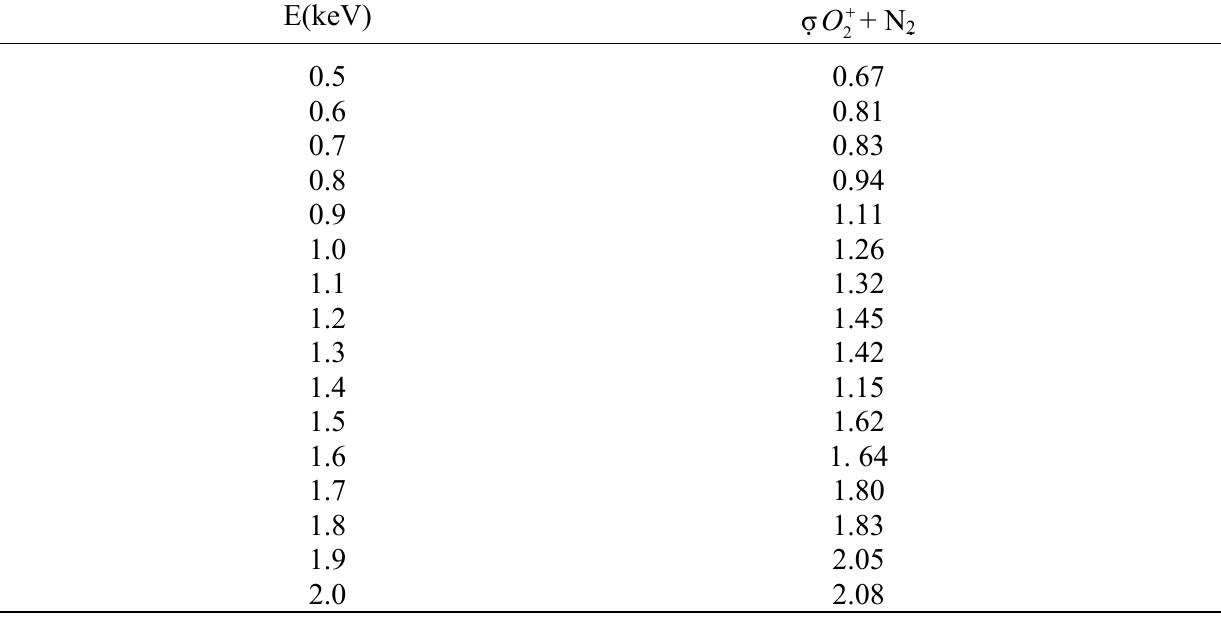
Table 1. Absolute total single-electron-capture cross sections, σ (Å 2 ), for + Overall uncertainties in each value